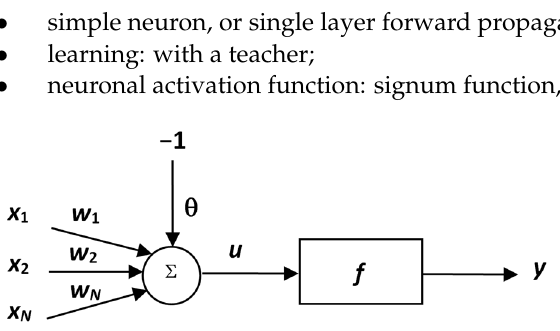
Figure 8. Data classification. The best-known structure of neural networks used today is the multi-layer percep- tron (MLP), which operates with a linear function and, by default, with a non-linear sigmoid activation function [27]. Many examples of MLP use in predictive maintenance, failure analysis, or defect occurrence prediction in industrial processes can be found in the literature, e.g., in works [28–31]. In some cases, a hyperbolic function (tanh) is also used, producing better results. MLP can be used both for quasi-regression tasks and for classification tasks. With dif- ferent types of features and customizations, it can serve well for both types of tasks. For classification, MLP is used for simple decision-making (single output) and multiple clas- sifications (multi-output). MLP networks are compact with a wide range of applications. MLP training algorithms include Back Propagation, Quick Propagation, Levenberg– Marquardt, Delta-bar-Delta, and several other modifications of training algorithms. Its significant advantage is its very fast solving of tasks. The disadvantage is slow training. An illustration of an MLP network with four layers is shown in Figure 9 [32].